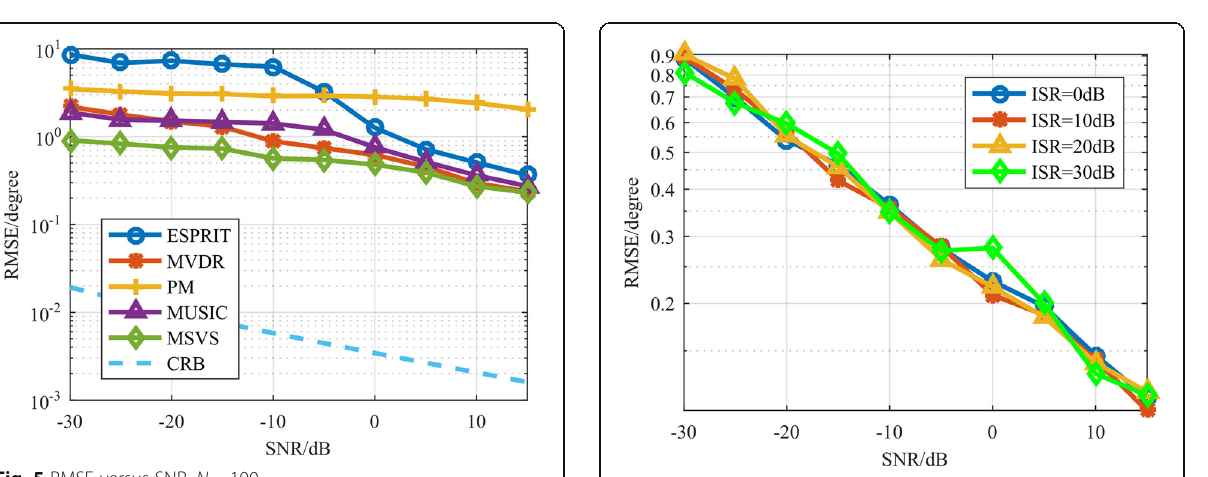
Fig. 7 RMSE with different ISR, N = 100